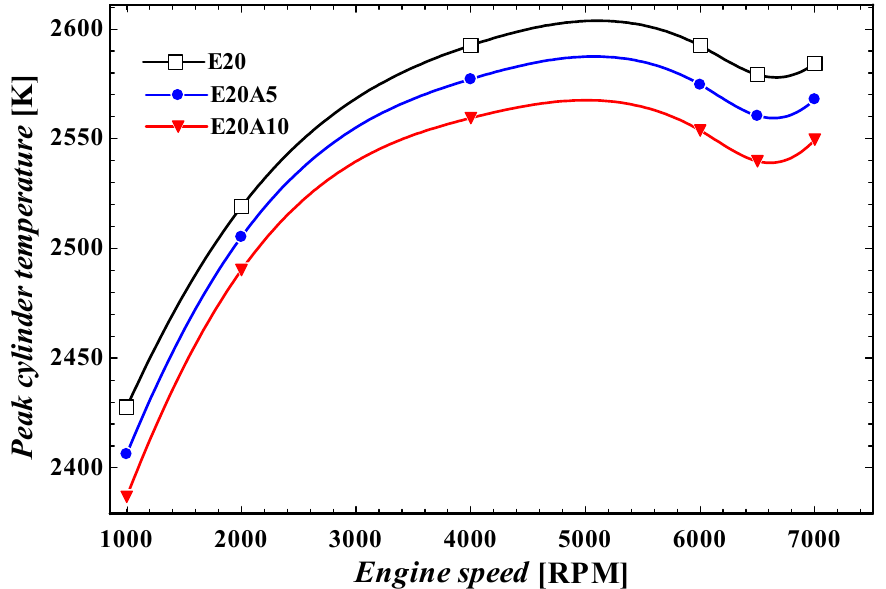
The main parameter affecting nitrogen oxide production is the in-cylinder combus-